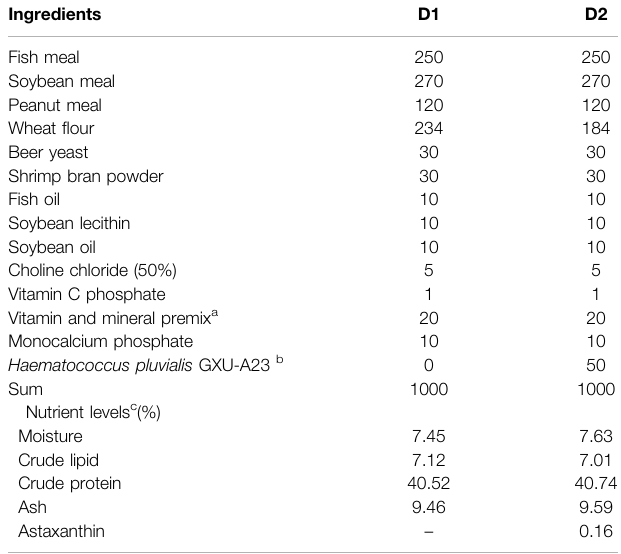
TABLE 1 | Ingredients and proximate compositions of two experimental diets (g/kg).